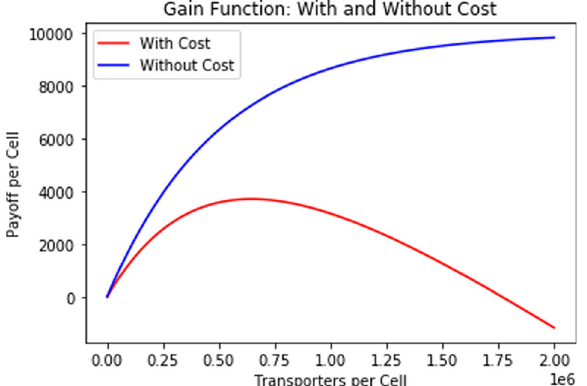
Fig. 10 GLUT1 inhibitor treatment payoffs with and without sucker ’ s gambit. Payoffs per cell are plotted as a function of number of competing cells. Under the sucker's gambit strategy, we see a clear depression of the payoff curve per cell, with negative payoff values.